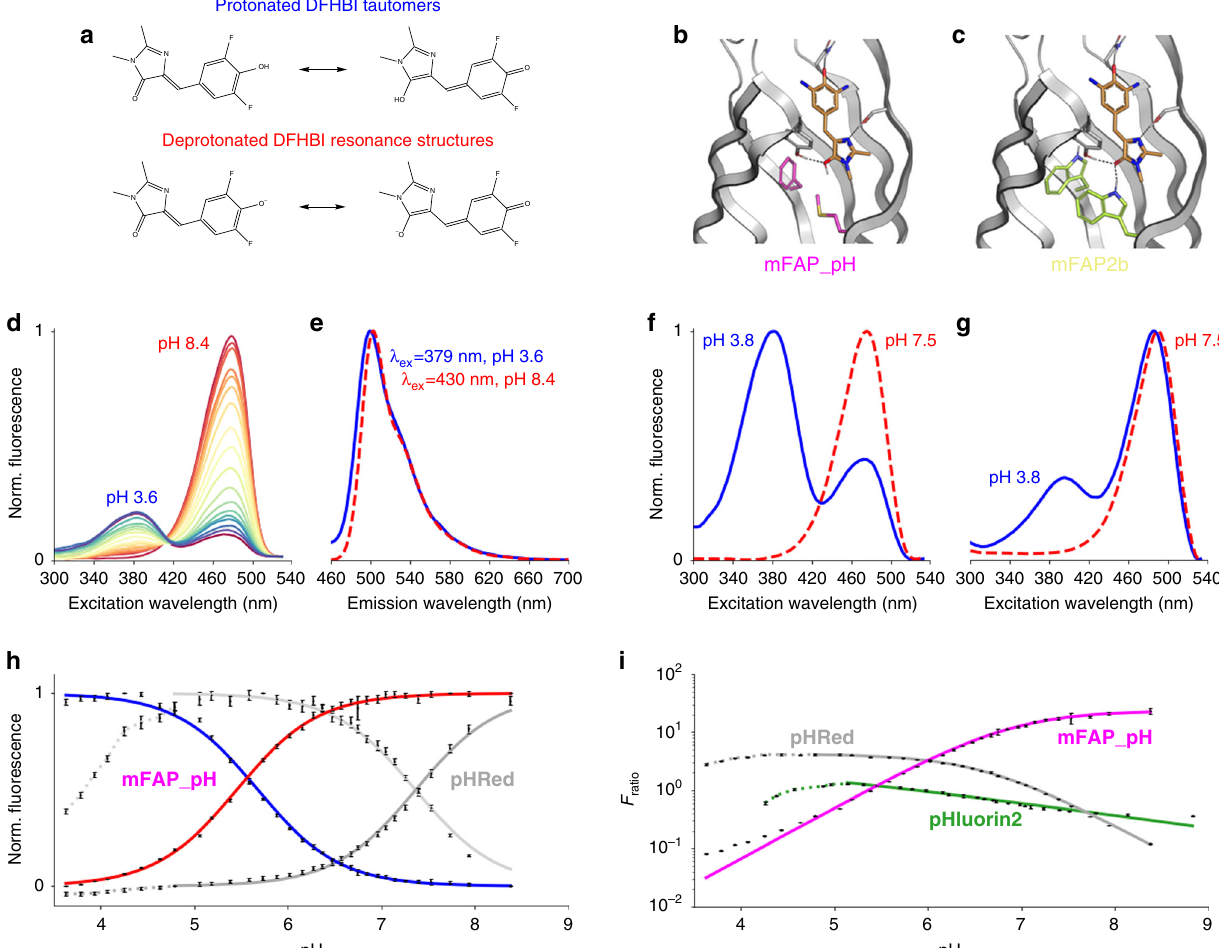
Fig. 3 Characterization of pH-responsive mFAP_pH. a – c Chemical basis of pH-responsiveness in mFAP_pH. a Chemical structures of protonated tautomers and deprotonated resonance structures of DFHBI. b , c Computational models showing the residues unique to b mFAP_pH (M27, F93) (magenta) and c mFAP2b (W27, W93) (lime) . The arrangement of intermolecular hydrogen bonds (black dotted lines) in b the mFAP_pH – DFHBI complex permits binding to both the phenolate and phenolic (shown) forms of DFHBI whereas of c the mFAP2b – DFHBI complex only permits binding to the phenolate (shown) form of DFHBI. d Normalized fl uorescence excitation spectra of the mFAP_pH – DFHBI complex for a pH titration between pH 3.6 and pH 8.4. e Normalized fl uorescence emission spectra of the mFAP_pH – DFHBI complex at pH 3.6 and pH 8.4. f , g Fluorescence excitation spectra normalized to pH 3.8 and pH 7.5 of f pH-responsive mFAP_pH – DFHBI complex and g pH-unresponsive mFAP2b – DFHBI complex. h Normalized mean ( n = 3) fl uorescence intensity from the pH titration of the mFAP_pH – DFHBI complex (blue and red) and previously reported pHRed (dark gray and light gray) , showing fl uorescence emission by exciting the blueshifted fl uorescence excitation peak (blue and dark gray) and fl uorescence emission by exciting the redshifted fl uorescence excitation peak (red and light gray) . i Ratiometric fl uorescence ( F – DFHBI complex (magenta) , pHRed ratio ) from the pH titration of the mFAP_pH (gray) , and pHluorin2 (green) . h , i The means are fi t to h a sigmoid or inverse sigmoid function or i a logistic function using non-linear least squares fi tting (lines) . The dotted lines indicate pH values at which the measured F ratio coincides with two different pH values, and therefore are not used in the fi ttings. Error bars represent the s.d. of the mean of three technical Fig. 19). Labeling CMs with DFHBI concentrations at approxi- robustly detectable Ca 2 + transients during cardiac contraction cycling and moderate photostability using ~3-fold higher laser power density (Fig. 5f). The image acquisition rate in these